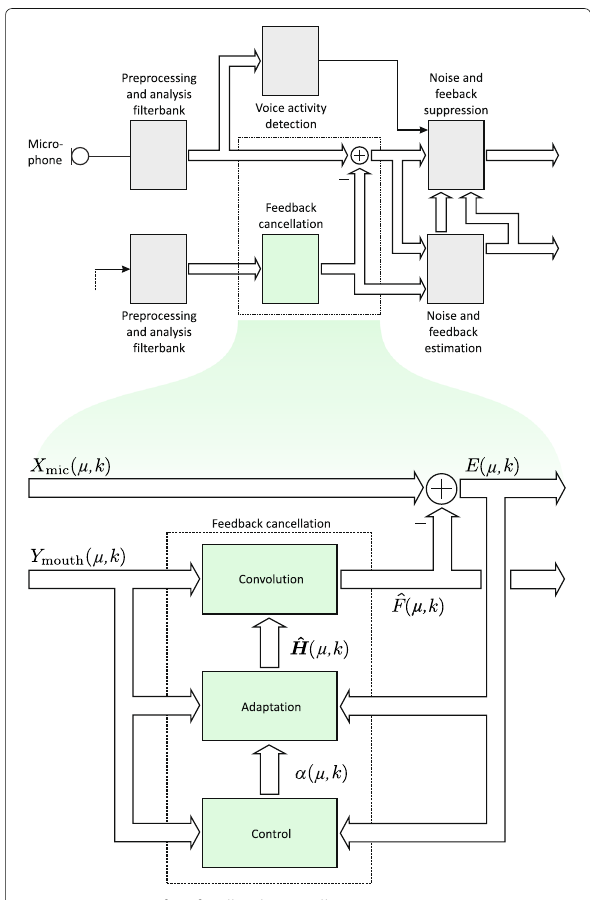
Fig. 7 Structure of an feedback cancellationsystem operating in subbands (according to